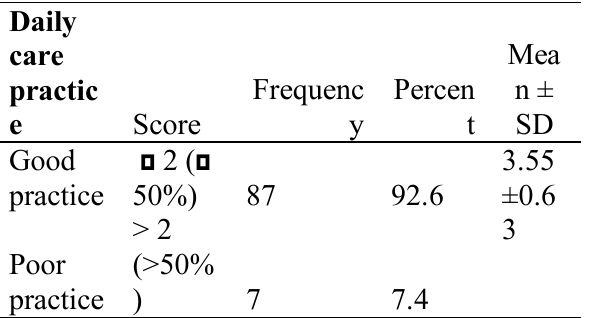
Table 9: Overall Self Care Efficacy Score